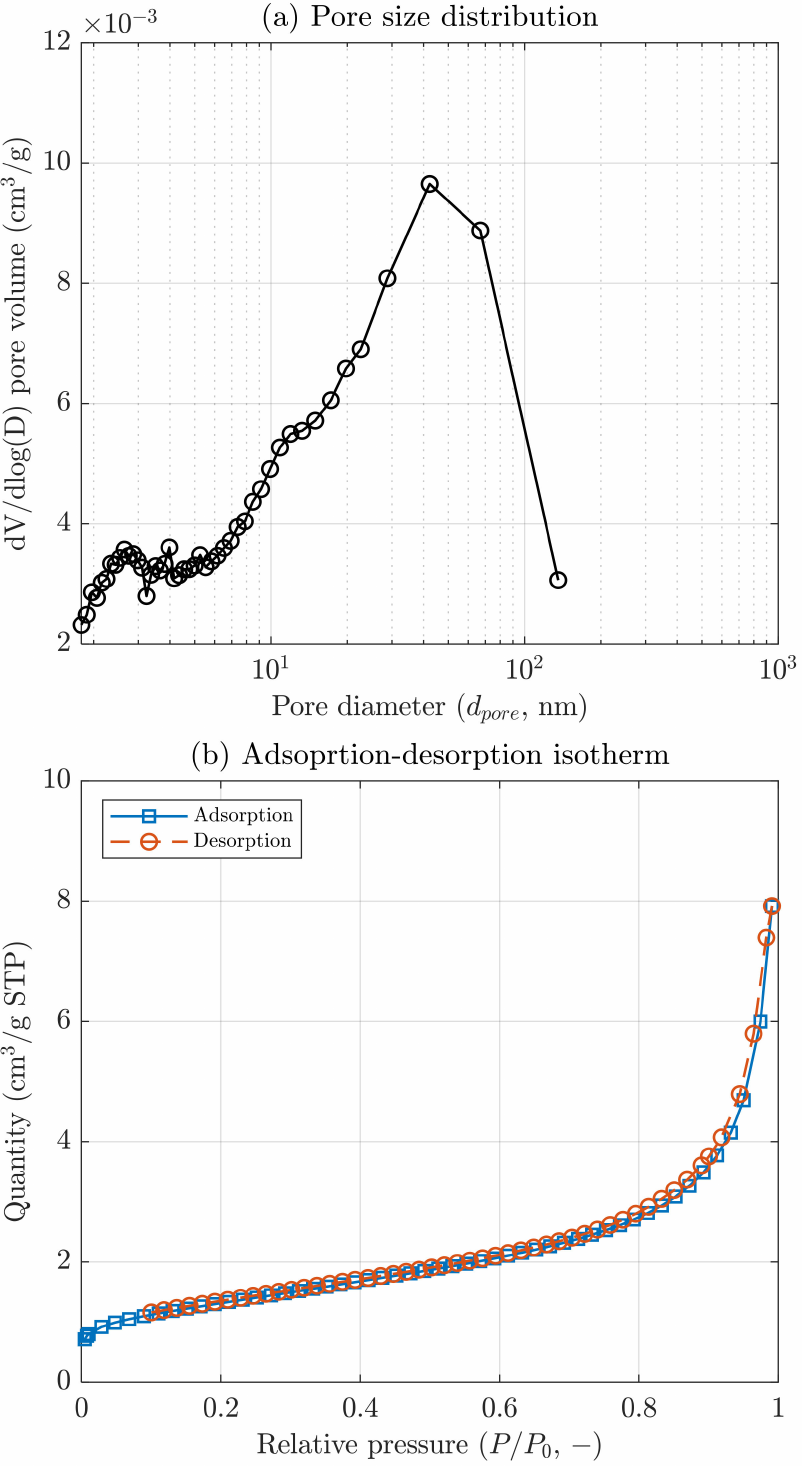
Figure 4. N 2 adsorption-desorption isotherm ( a ) and pore size distribution ( b ) of the GMC-Y3